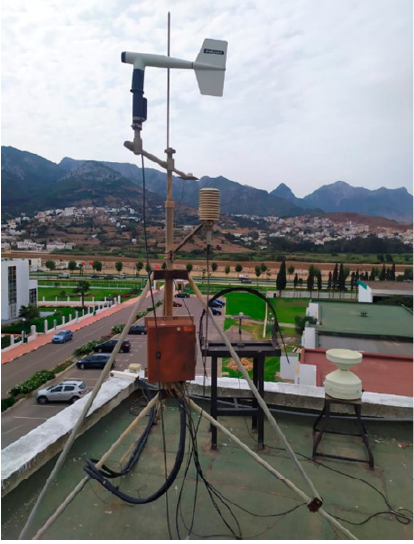
Figure 1. Weather station of Abdelmalek Essaadi University, Faculty of Sciences, Morocco. In Figure 2, we plot the daily range of the mean (T mean ), maximum (T max ), and minimum (T min ), temperature. The three-temperature dataset describes the timescale distribution of day-to-day temperature variations in the Tetouan and Tangier sites. The annual temperature variation reveals the succession of warm and cold periods over the year. The analysis is conducted for each day. The recorded T max was observed in the July period (38 ◦ C for Tetouan and 36.6 ◦ C for Tangier), while the T min was observed in the January period (6 ◦ C for Tetouan and 2 ◦ C for Tangier). The distribution of the T min is close to normal condition.